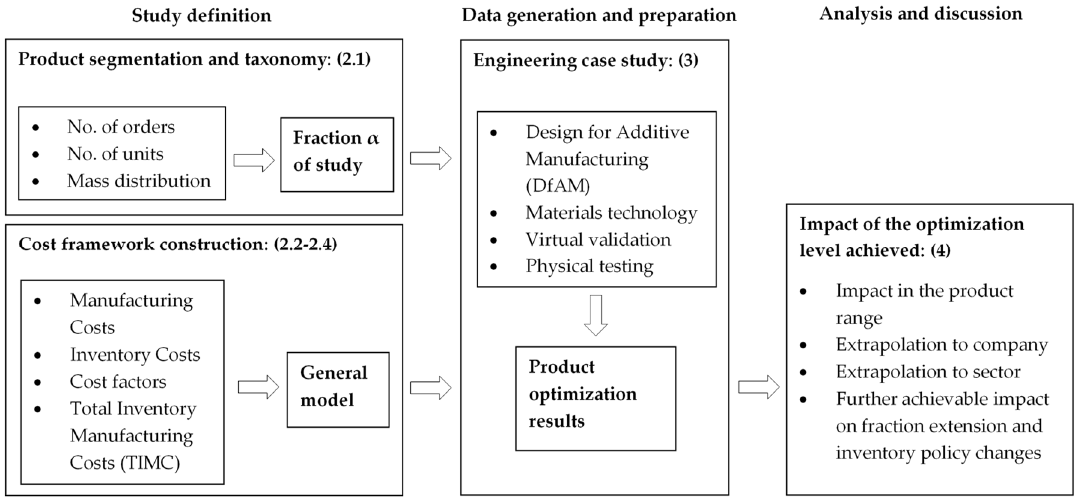
Figure 1. Flow diagram of the present study methodology.